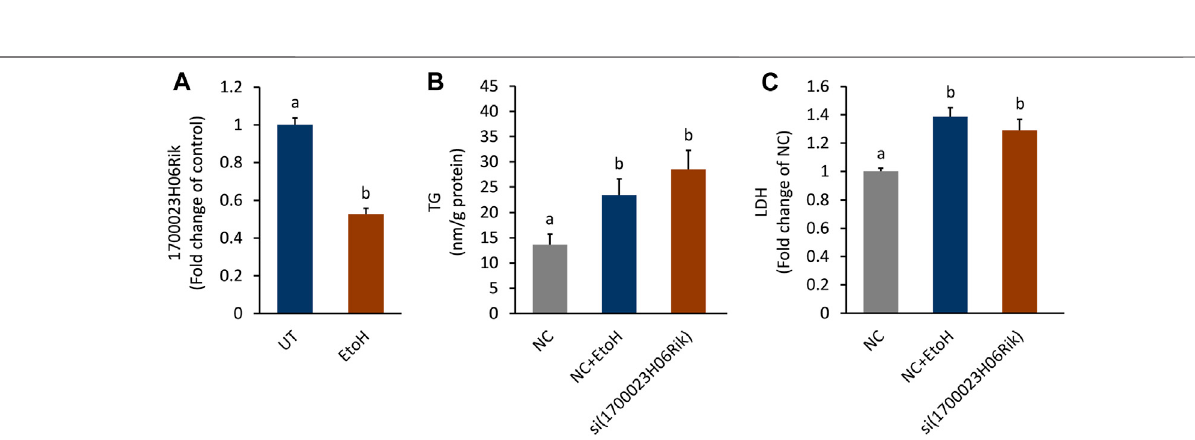
Frontiers in Pharmacology |